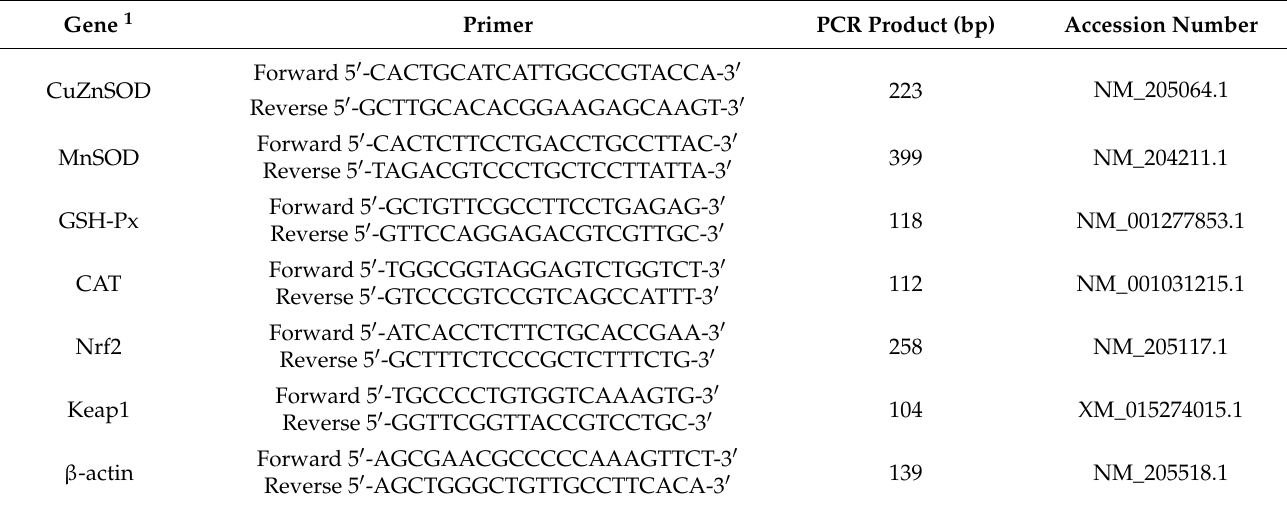
Table 2. Sequences of real-time PCR specific